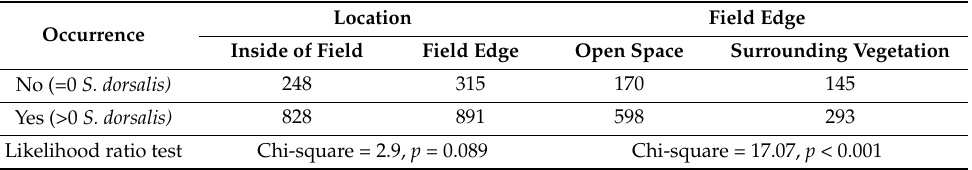
Table 3. Occurrences of S. dorsalis on blueberry plantings, inside of field or near field edges and with open space or surrounding vegetation, in central Florida during the summers (June–September) of 2017 and 2018.